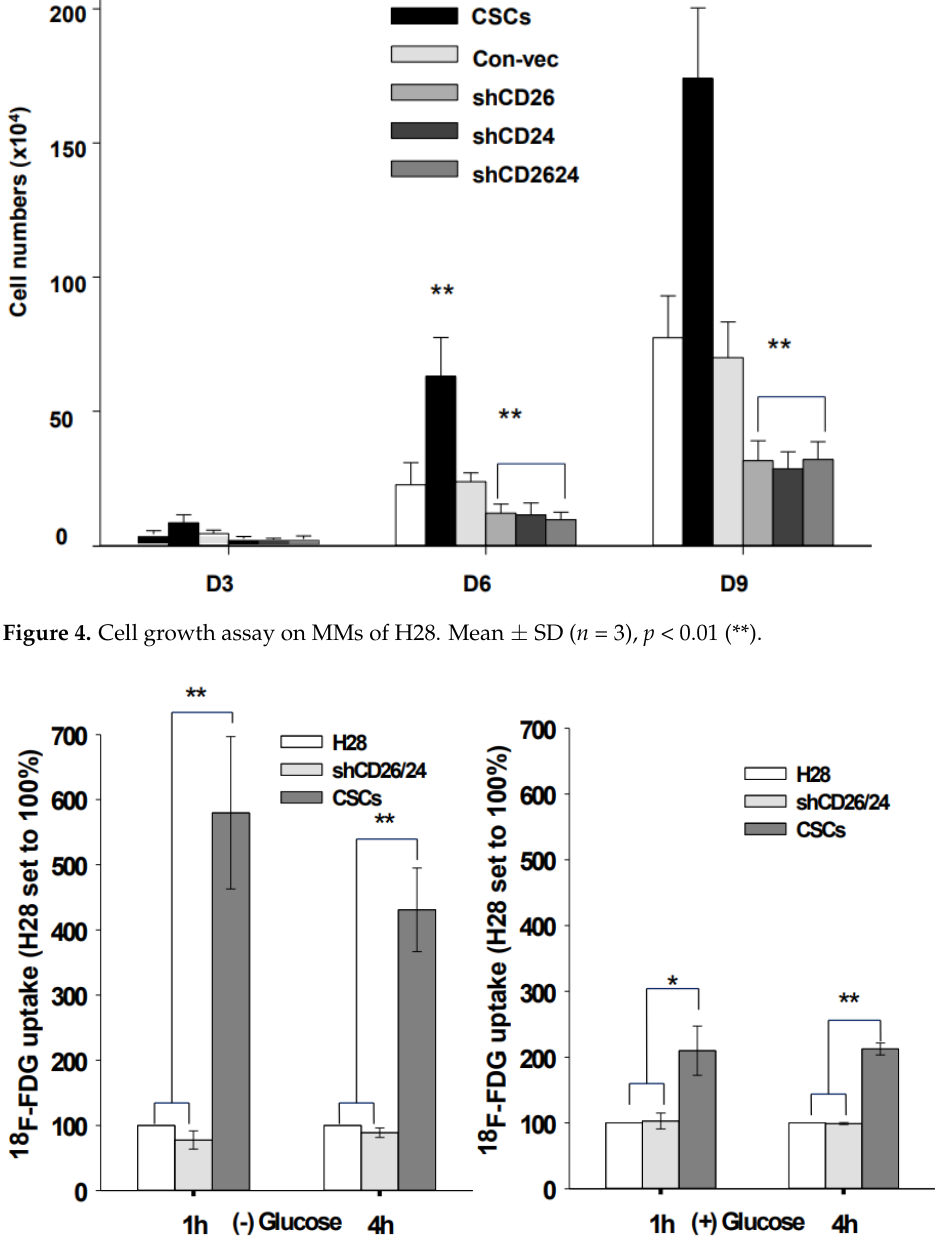
Figure 5. 18 F-FDG uptake in MMs incubated in glucose-free or glucose-containing medium. MMs were incubated with 20 µCi of 18 F-FDG for 1 or 4 h at 37 °C. In some plates, glucose was excluded from media because it competes with FDG uptake. After removal of excess tracer, cellular tracer uptake was measured by using a gamma counter to evaluate metabolic activity in MMs and tracer uptake was corrected for the number of cells. 18 F-FDG uptake in shRNA and CSCs was compared with that in H28 cells. Mean ± SD ( n = 3), p < 0.05 (*), and p < 0.01 (**).